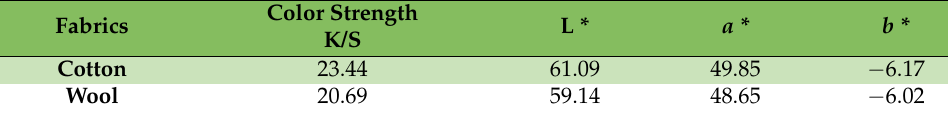
Table 2. Color strengths of fabrics dyed with reactive red 195.